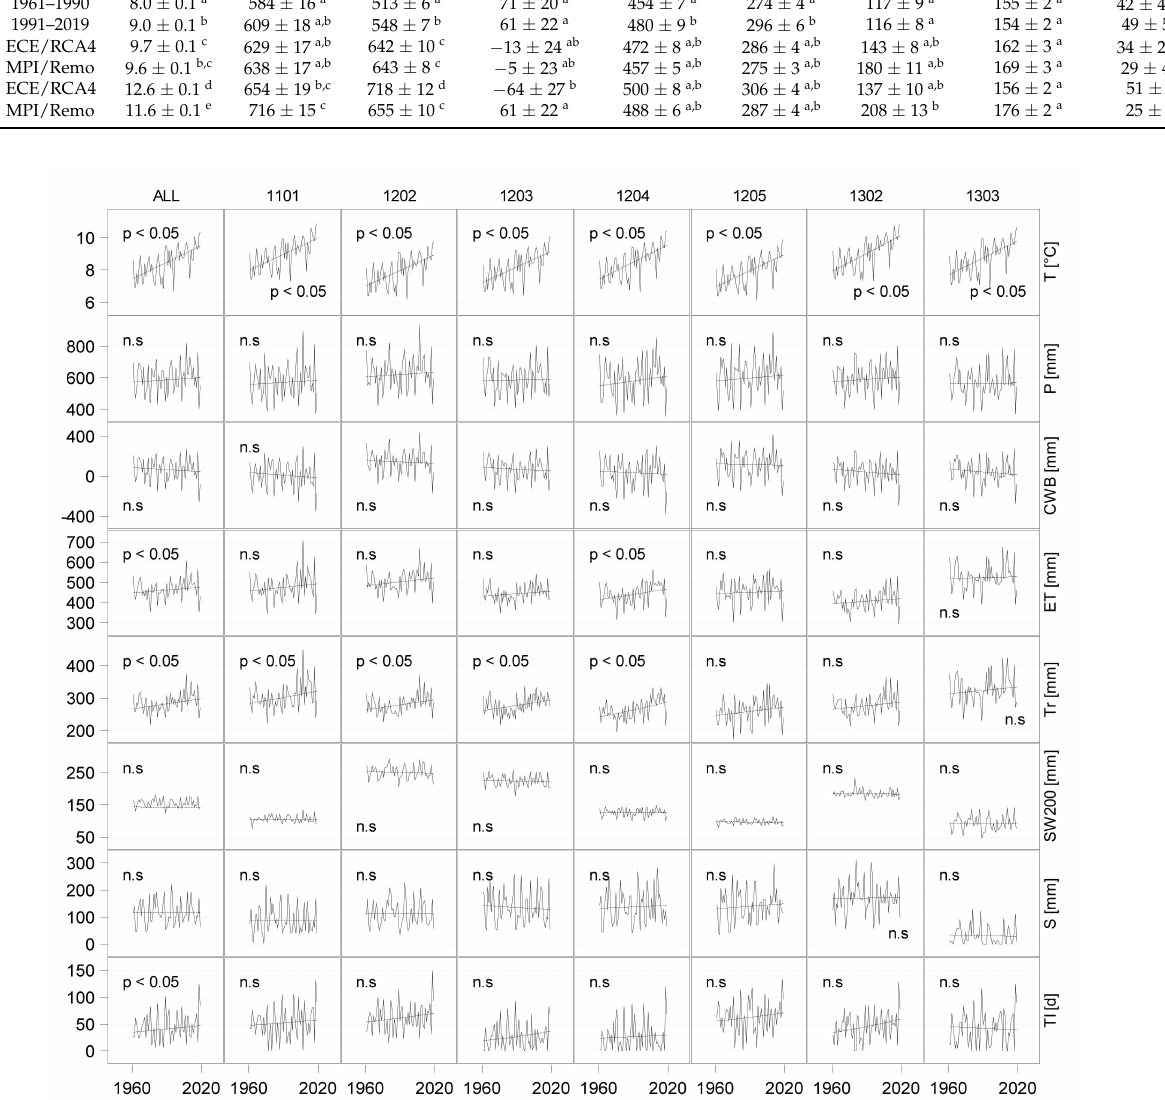
Figure 3. Trendline and annual values within the time period 1961–2019 of temperature (T), precipitation (P), climate water balance (CWB), actual evapotranspiration (ET), transpiration (Tr), plant-available soil water down to a depth of 200 cm (SW200), seepage (S) and dry days (TI), with columns = sites and total sample (ALL). Significant slope is denoted by p < 0.05, non-significance by